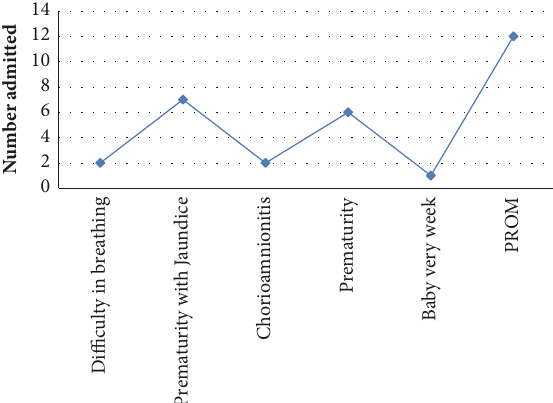
Figure 2: Clinical assessments of the selected babies (reasons for